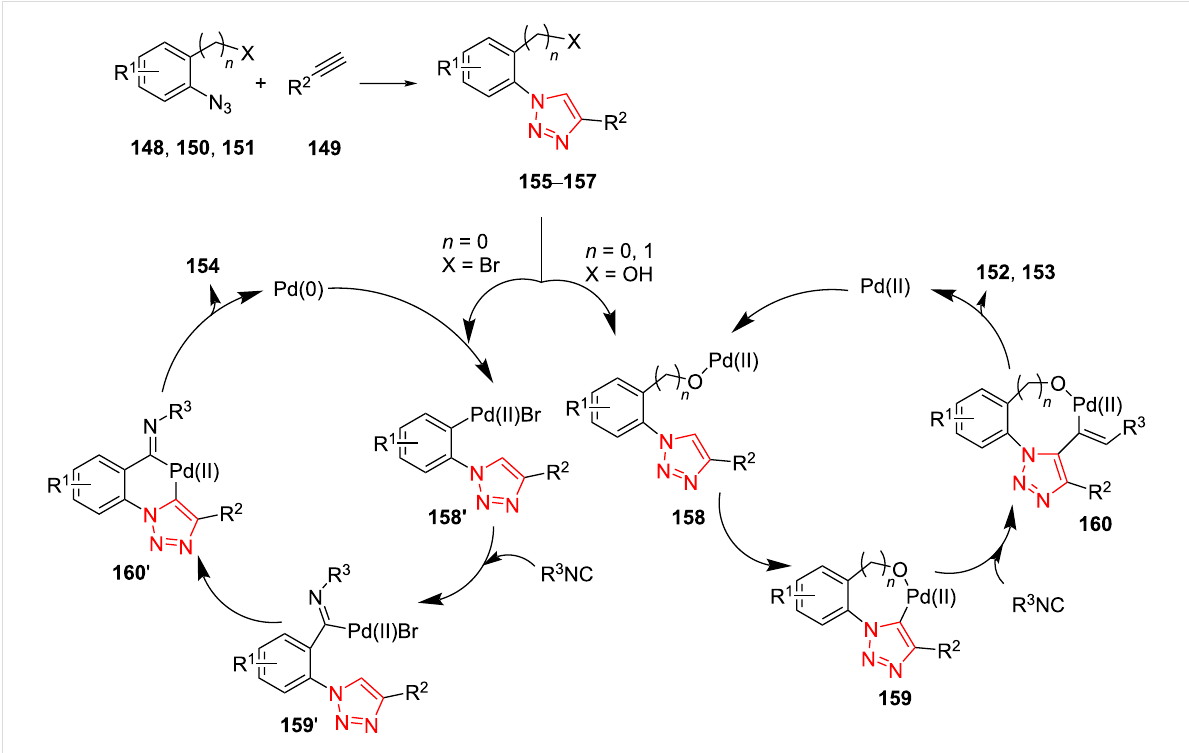
Scheme 43: A probable mechanism for the synthesis of highly functionalized 1,2,3-triazole-fused 5-, 6-, and 7-membered rings 152 – 154 ,